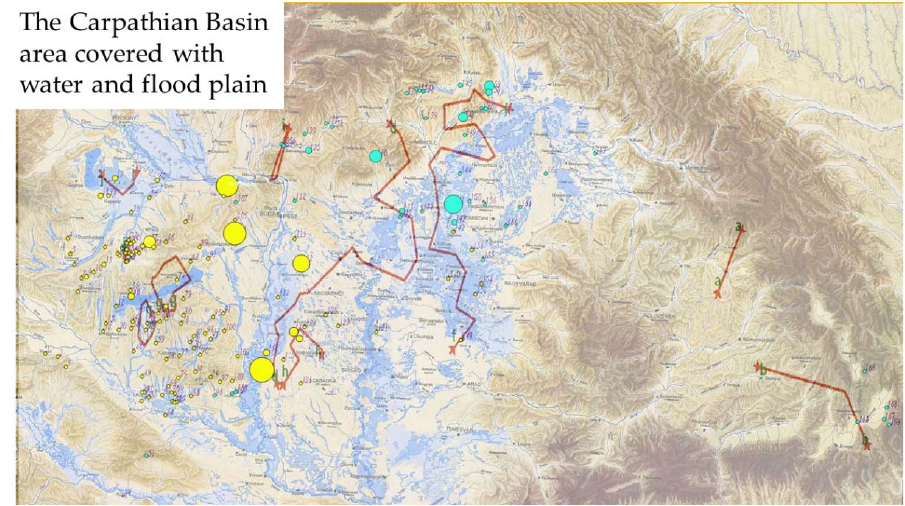
Figure 3. The results of the genetic analysis (Geneland) compared with the geographic analysis (Barrier), represented on the hydrographic map of the Carpathian Basin in the mid ‐ 1800 ′ s. Red lines indicates the possible barriers to gene flow.